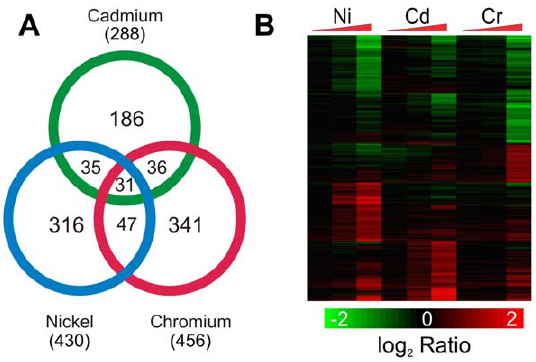
Figure 1. Nickel, chromium, and cadmium exposures affect different groups of genes. (A) An ANOVA was used to identify differentially expressed probe sets using an FDR , 0.001 and a 1.8 fold change filter. In total, 992 probe sets were differentially expressed in at least one metal exposure. The differentially expressed genes may be found in Tables S2 and S3. (B) Hierarchical clustering demonstrates that some probe sets respond to only a single metal while others respond to two or three. Dose dependent responses are evident. Each column represents a treatment condition and each row represents an individual probe set. The triangles indicate increasing concentrations of metals and the color indicates the log 2 ratio of control to experimental expression